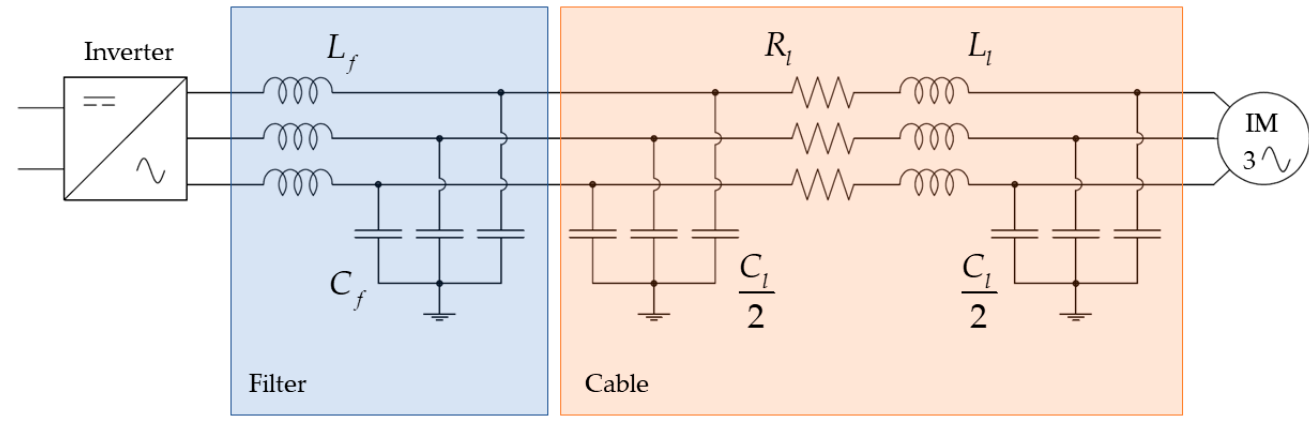
Figure 5. Simplified system model.